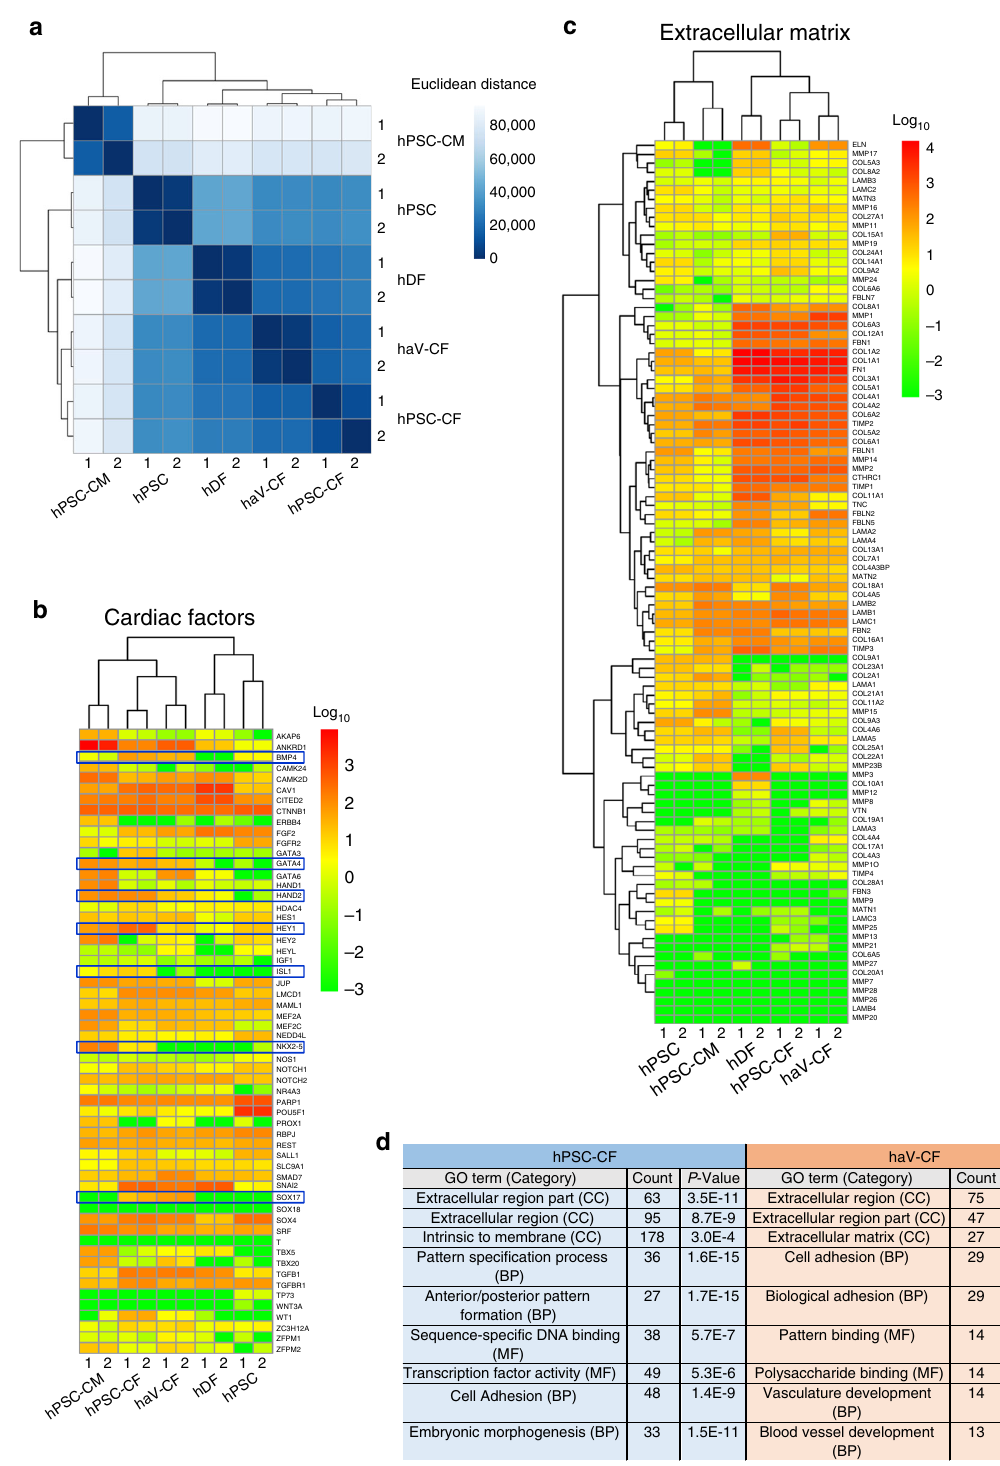
Fig. 7 Gene expression by RNA-seq in CF compared to DF, hPSC-CM, and hPSC. a Dendrogram showing the similarity in the abundance of overall transcripts (19,084 genes) across samples of hPSC-CF, haV-CF, hDF, hPSC-CM, and hPSC that was calculated by Euclidean distance. b Heatmap of cardiac factors (58 genes) expression across samples of hPSC-CF, haV-CF, hDF, hPSC-CM, and hPSC organized by unsupervised cluster analysis. c Heatmap of extracellular matrix related gene expression (98 genes) across samples of hPSC-CF, haV-CF, hDF, hPSC-CM, and hPSC presented by unsupervised cluster analysis. d Gene ontology (GO) analysis using the functional annotation tool (DAVID Bioinformatics Resources 6.7, NIAID/NIH) for the differentially expressed genes in hPSC-CF and haV-CF (Supplementary Data 1 and 2) with calculated p values shown. The hPSC line used for RNA-seq are DF19-9-11T hiPSCs. The haV-CFs are from Lonza, NHCF-V, and hDFs are from 020a line. The TPM values from the RNA-seq were used for the